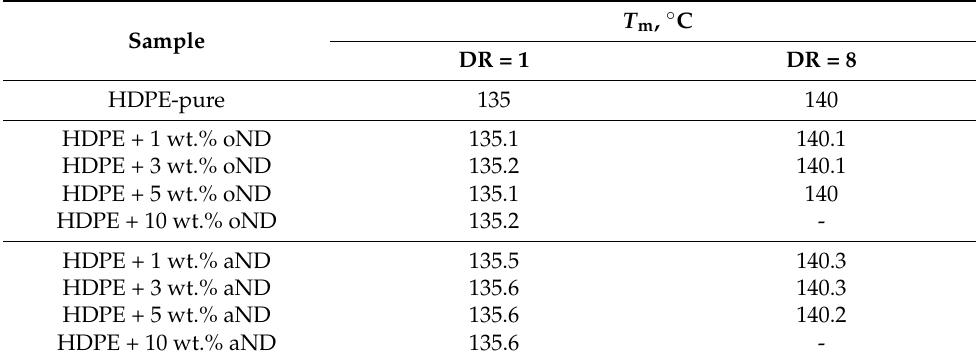
Table 1. Dependence of the melting temperature ( T m ) on the nanofiller content in the composite Figure 1. and after (DR = 8) orientation